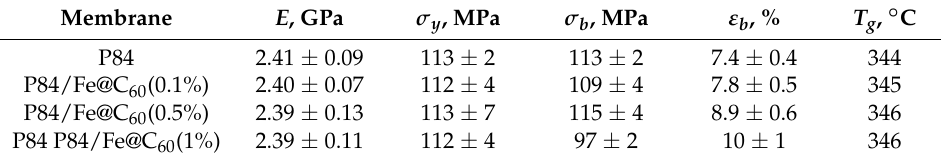
Table 1. Mechanical properties and glass transition temperature of membranes.